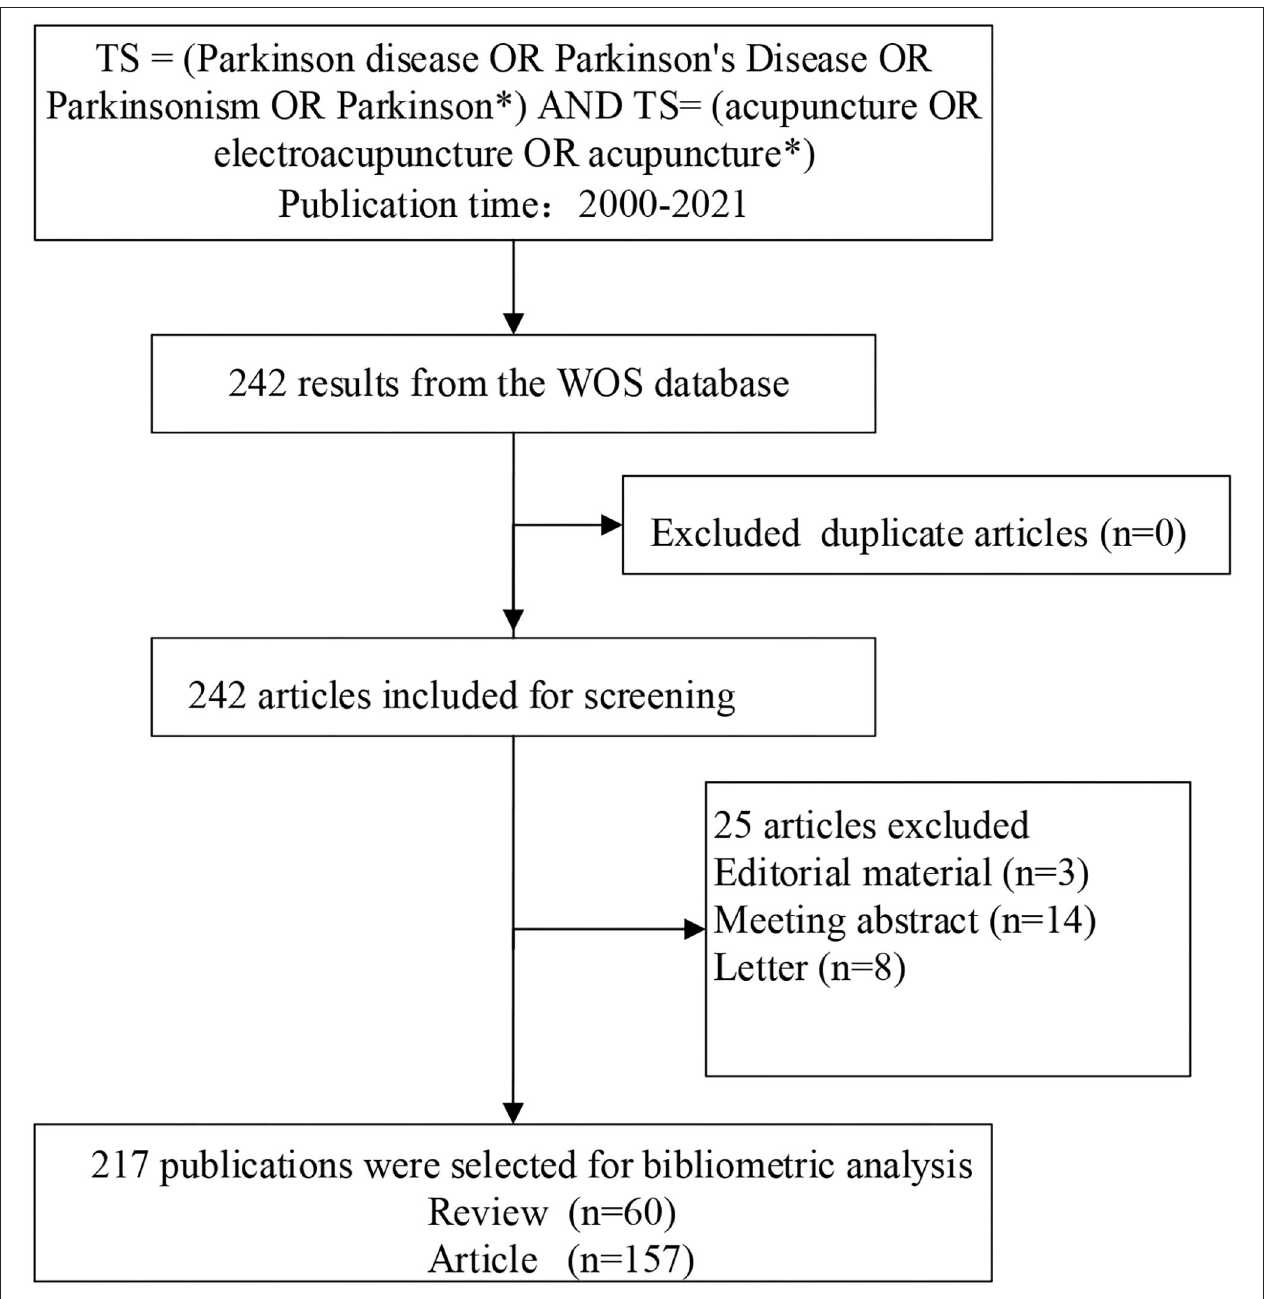
FIGURE 1 | Flowchart of the selection process for the eligible